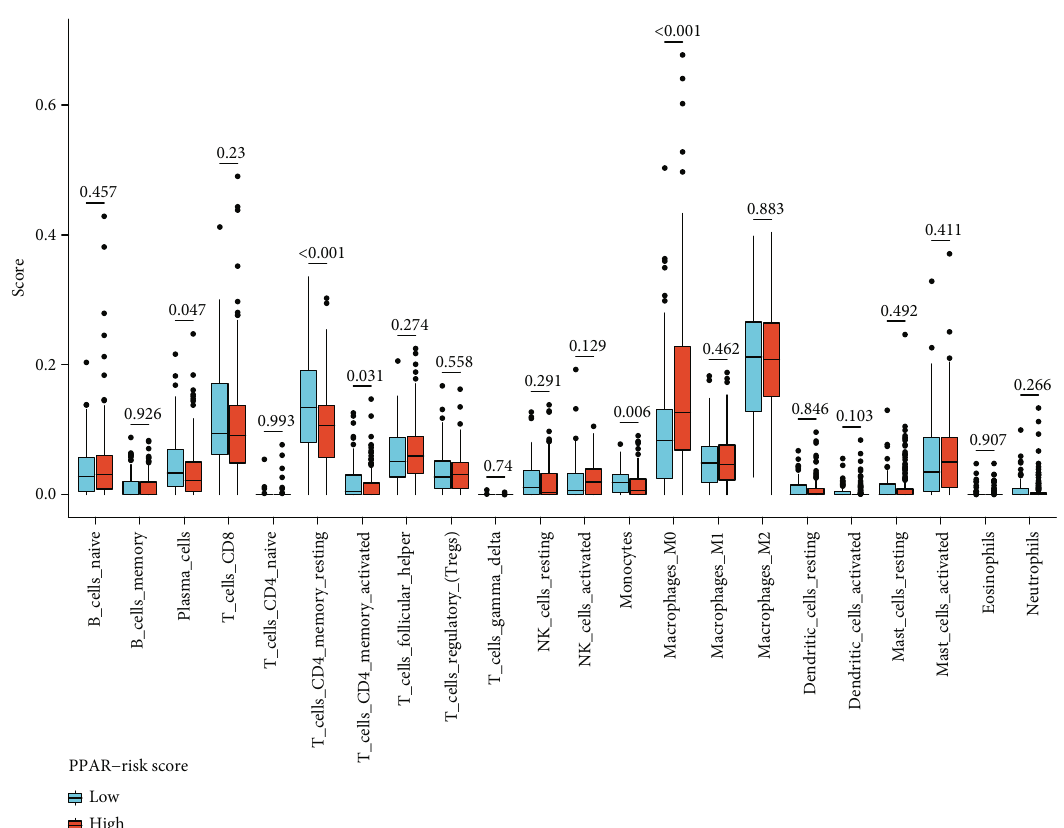
Figure 6: Boxplot compared the expressions of 22 immune cells in fi ltrating between the high- and low-risk Riskscore via the CIBERSORT algorithm. Each red blot signi fi ed the high-risk scores, and each blue dot represents the low-risk